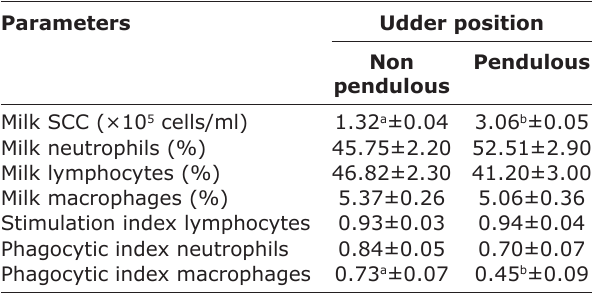
Table-4: Effect of udder position on milk SCC, milk DLC and in vitro activity of milk leukocytes in high yielding crossbred